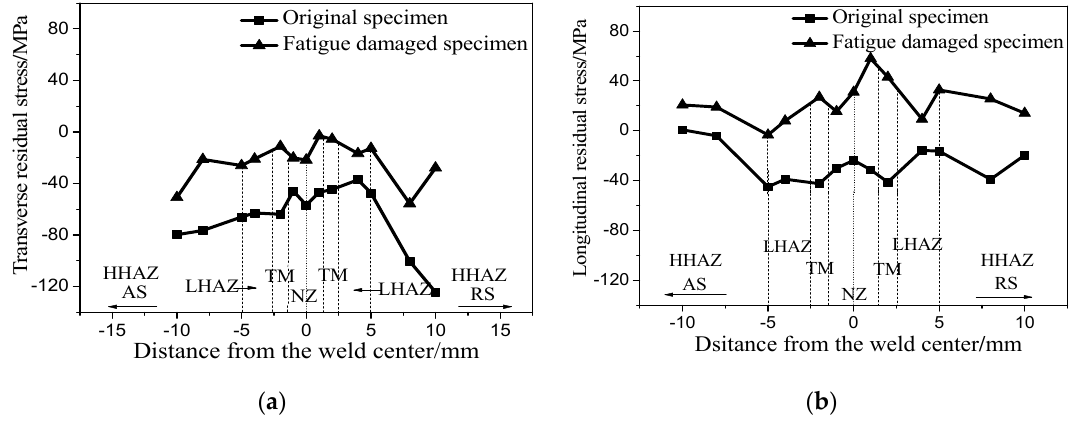
Figure 6. ( a ) Transverse and ( b ) longitudinal residual stress distributions of lower surface in the joint.